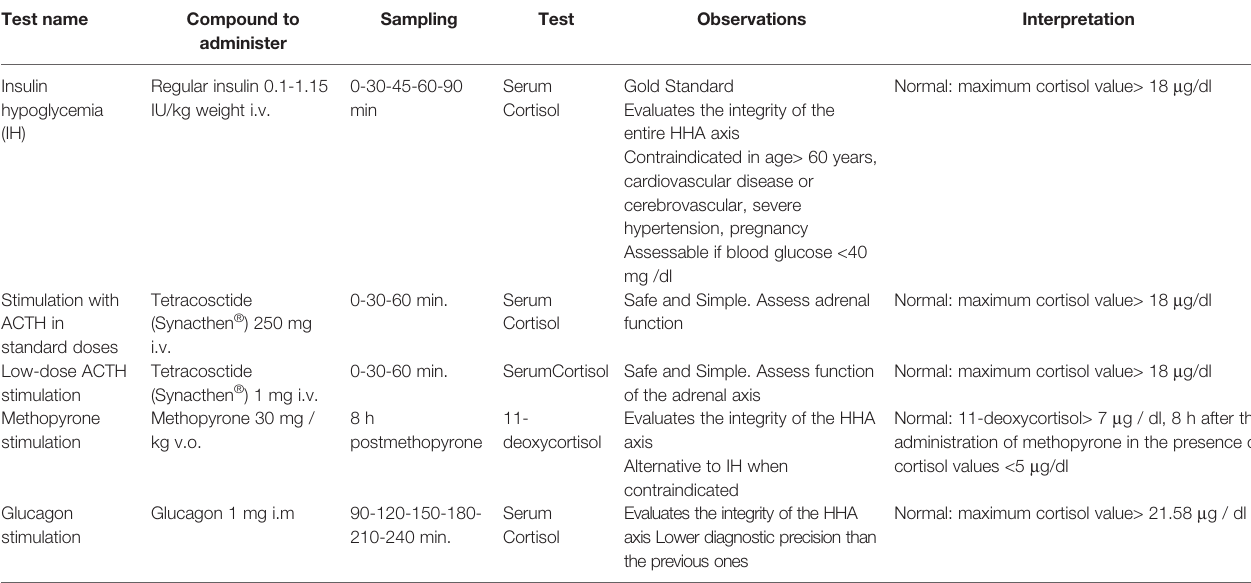
TABLE 1 | Dynamic tests for the study of adrenal